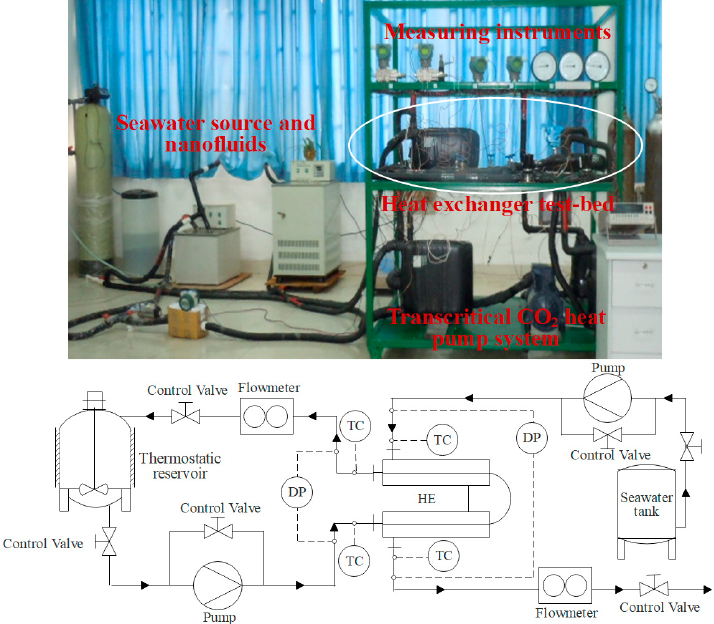
Figure 1. Heat pump system with seawater source and heat exchanger testbed.